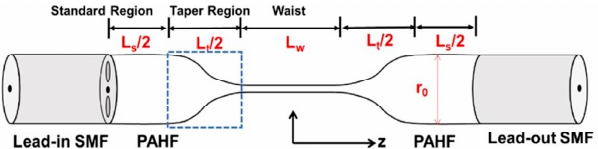
Figure 11. Schematic diagram showing the taper profile of the PAHF-based microfiber [97].